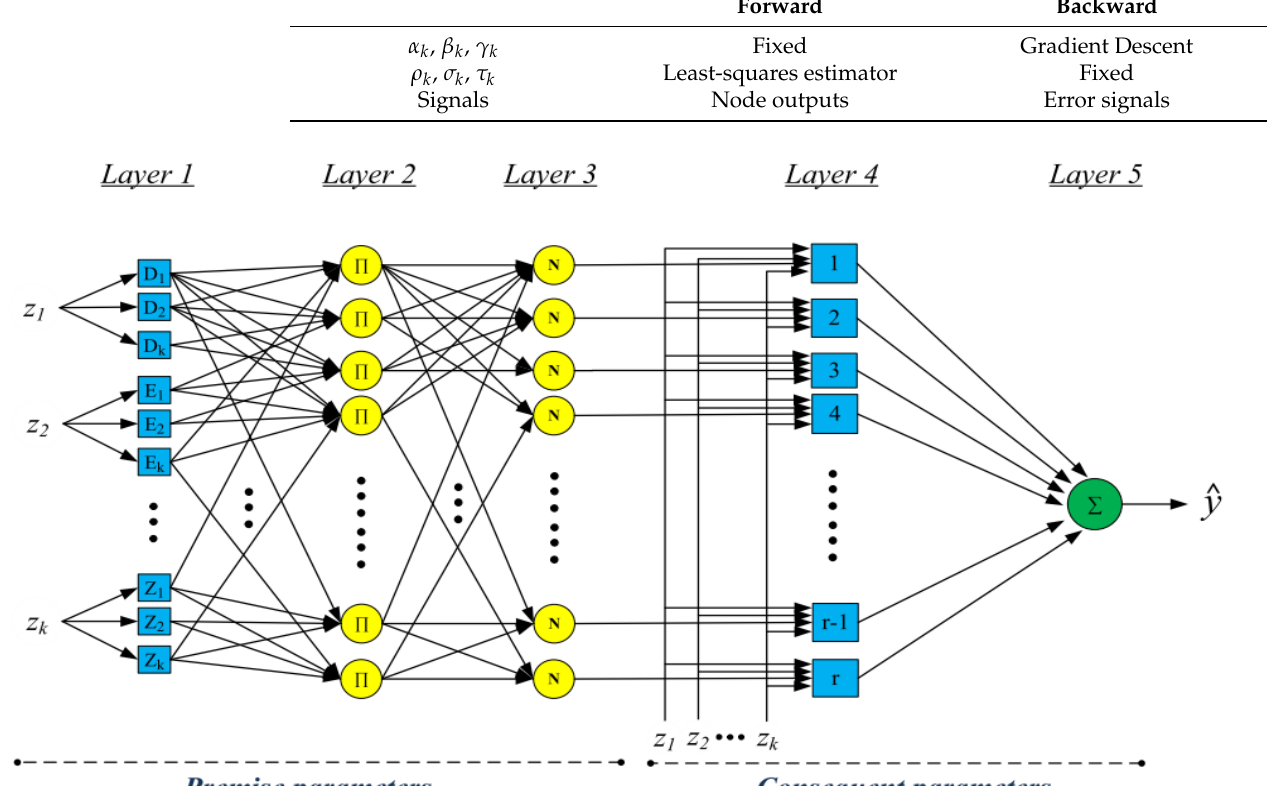
Figure 5. Wavelet-ANFIS testing flowchart.